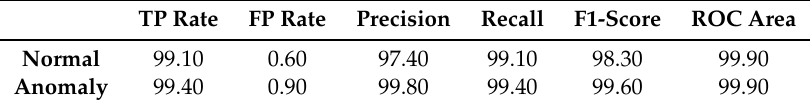
Table 10. Classification report for Adaboost